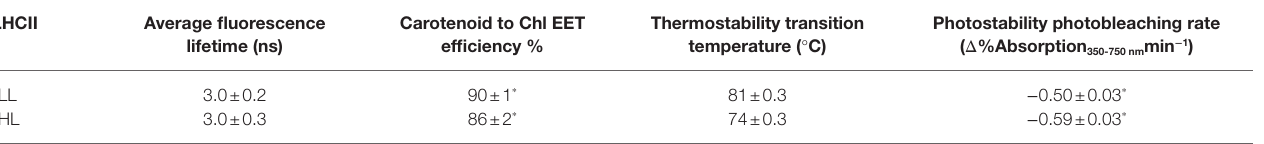
Fluorescence lifetime (438 nm excitation, 680 nm detection, n = 4). Errors represent the SD. Carotenoid to Chl excitation energy (EE) transfer (EET) efficiency, normalized to Chl a (assuming 100% transfer, n = 3). Errors represent the SE ( Figures 5A , B ; Supplementary Figure S5 ). Thermostability ( Figure 5C ). Photostability ( Figure 5D , n = 2). Errors represent the error of the fit. n = number of biological replicates. * p <